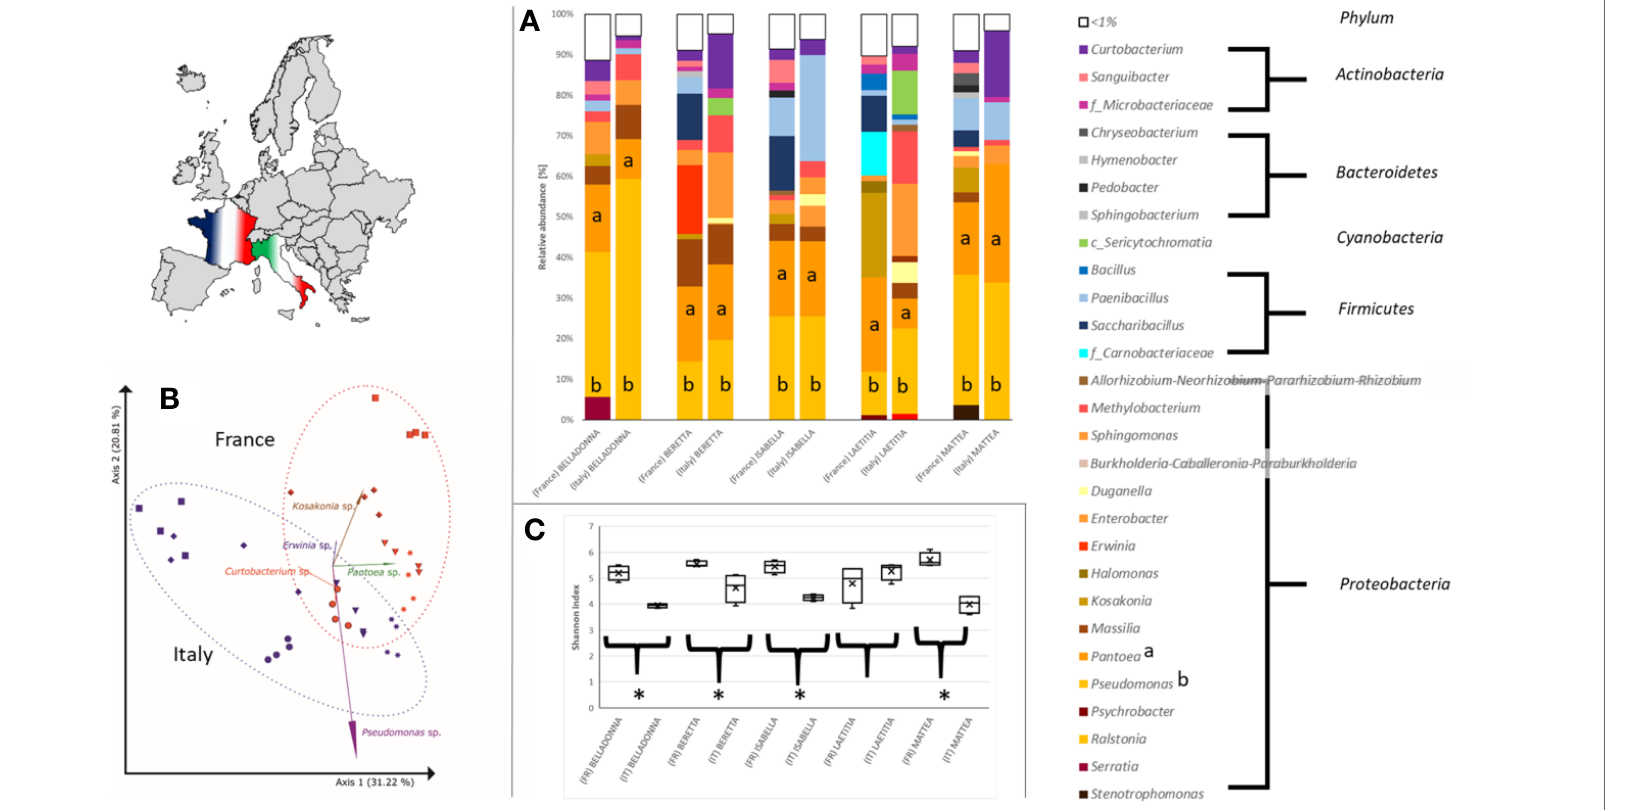
FIGURE 2 | Differences in the bacterial community in sugar beet cultivars ’ seeds due to origin. (A) Seed microbial community on genus level. All seeds are dominated to a different extent by Proteobacteria , especially Pseudomonas (a) and Pantoea (b). (B) PCoA-biplot of Bray-Curtis distance on genus level. Seed communities clearly cluster according to seed origin; spheres: cv. BELLADONNA; diamonds: cv. BERETTA; triangles: cv. ISABELLA; squares: cv. LAETITIA; stars: cv. MATTEA. (C) comparing Shannon diversity in seeds within the same cultivar due to seed origin; all seeds originating from France show a higher alpha diversity except cv. LAETITIA; * = signi fi cantly differing according to Kruskal-Wallis test depending on seed